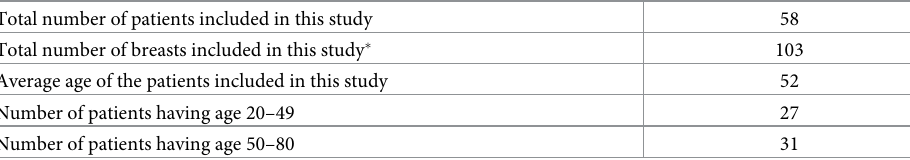
Table 1. Summary of the patient population used in this study. Total number of patients included in this study Total number of breasts included in this study � Average age of the patients included in this study